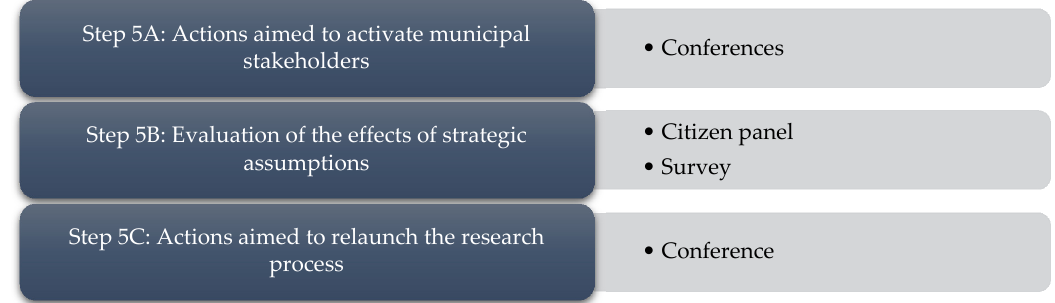
Figure 8. Operationalisation scheme Stage 5 of the research process.